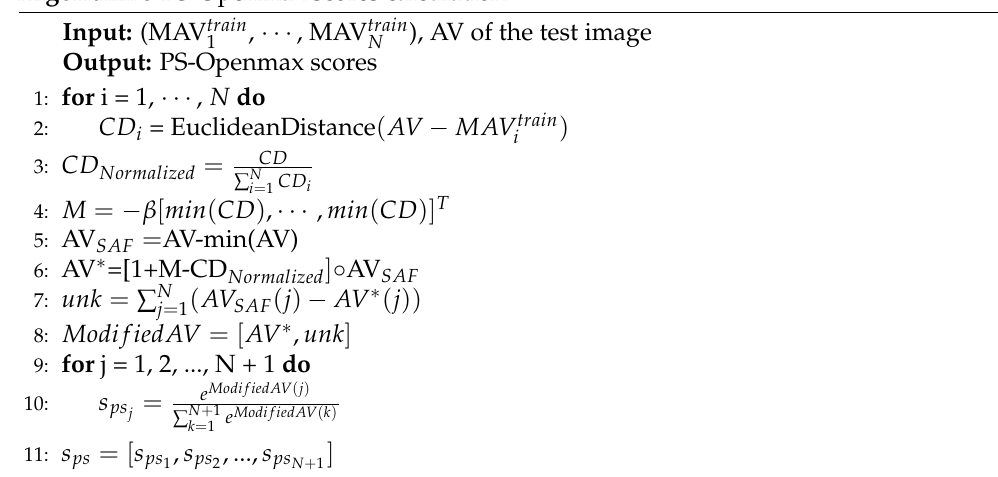
Algorithm 3 PS-Openmax scores